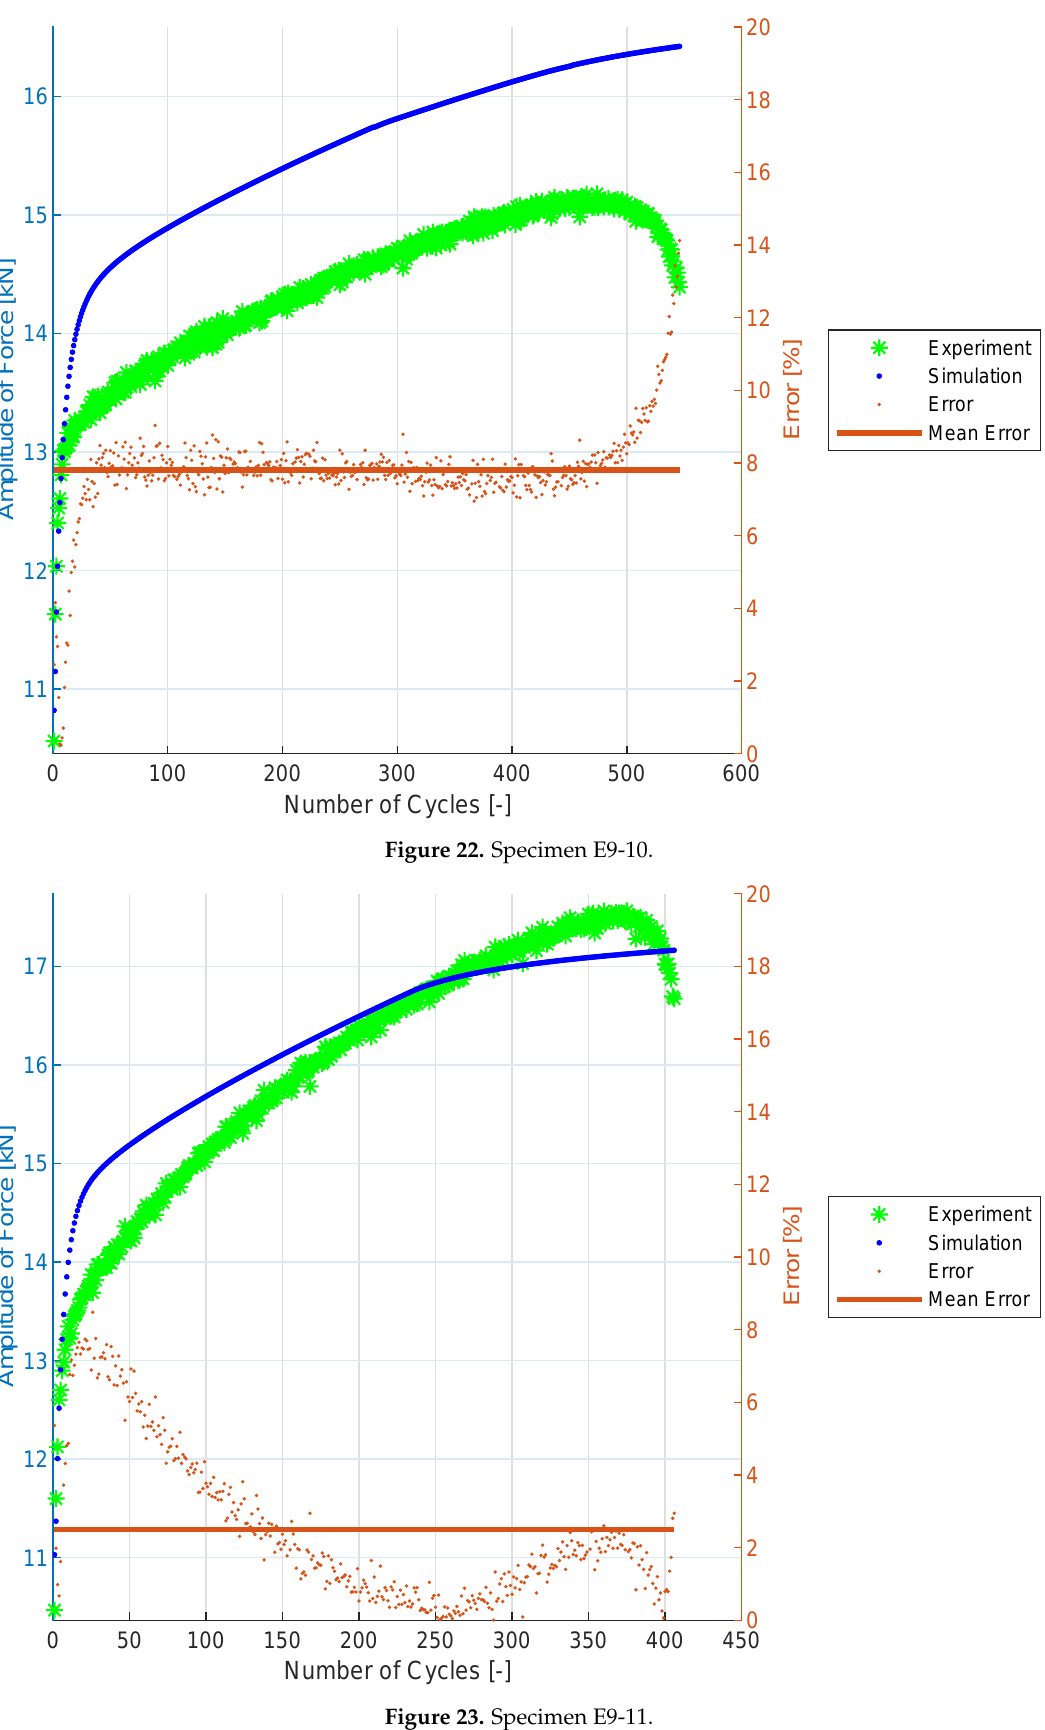
Figure 23. Specimen